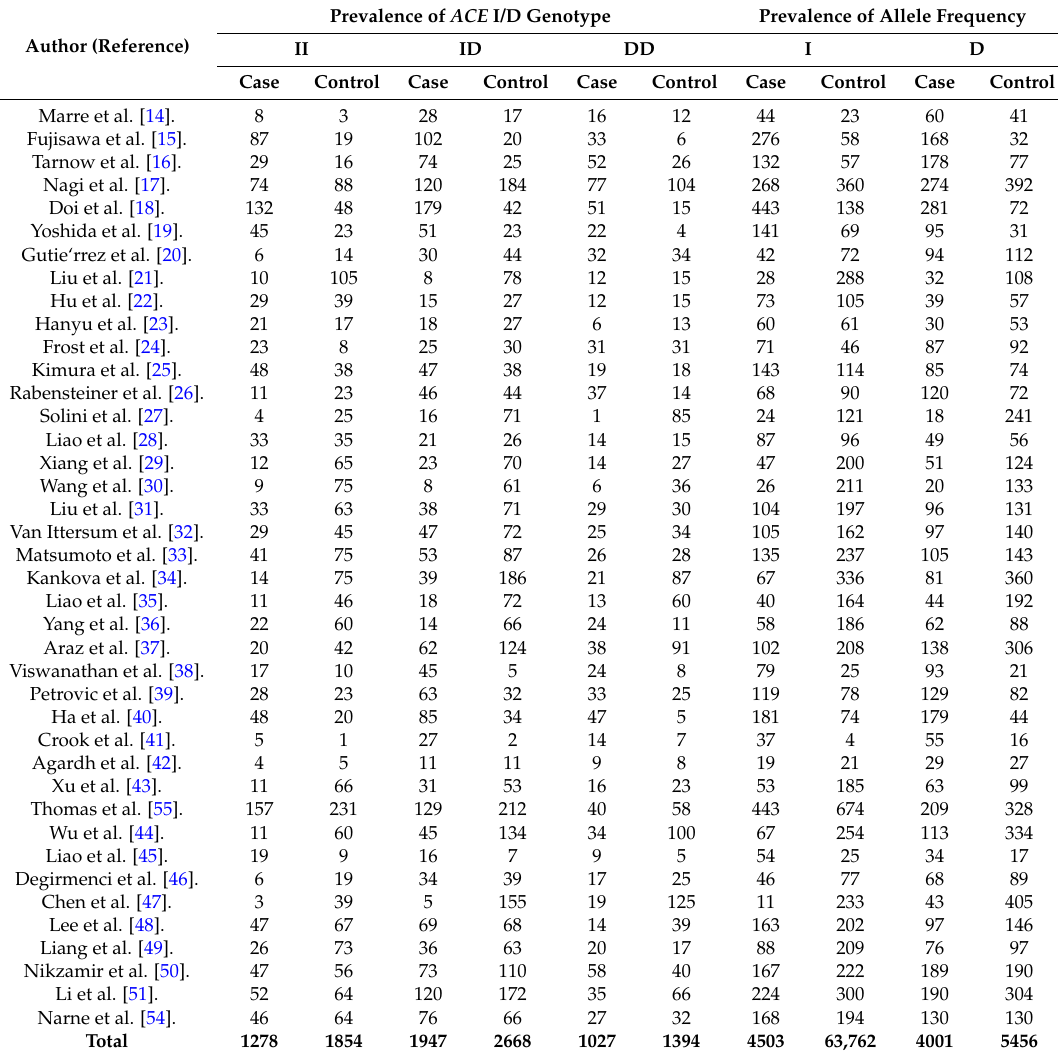
Table 2. The details on ACE I/D (angiotensin-converting enzyme insertion/deletion) polymorphism allele/genotype